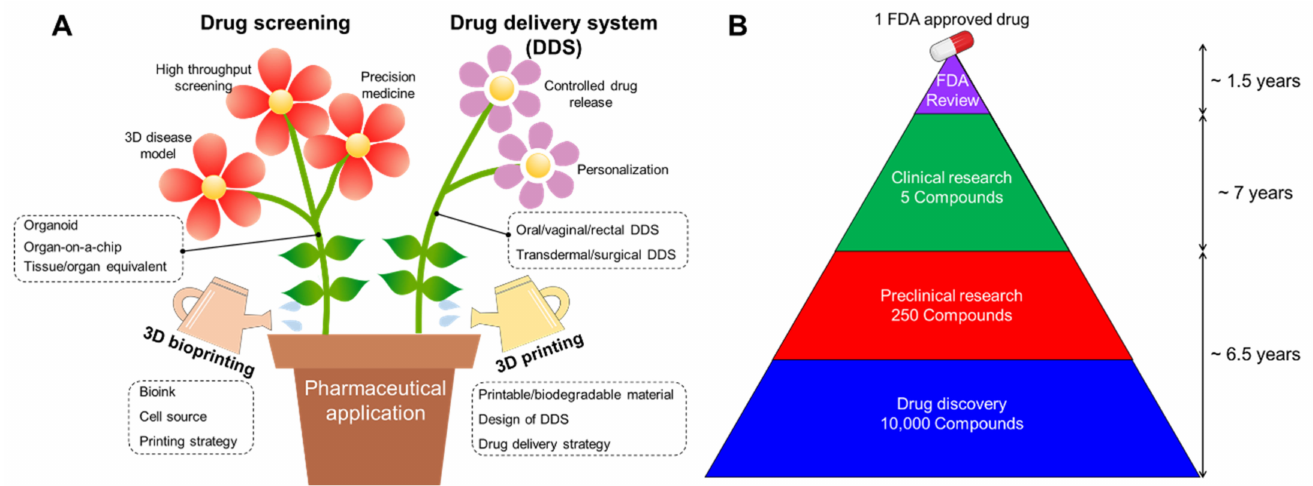
Figure 1. ( A ) Schematic illustration showing advances in pharmaceutical applications, including drug screening and drug delivery system (DDS) by employing 3D printing and bioprinting technology. ( B ) Average drug development timeline for one FDA-approved